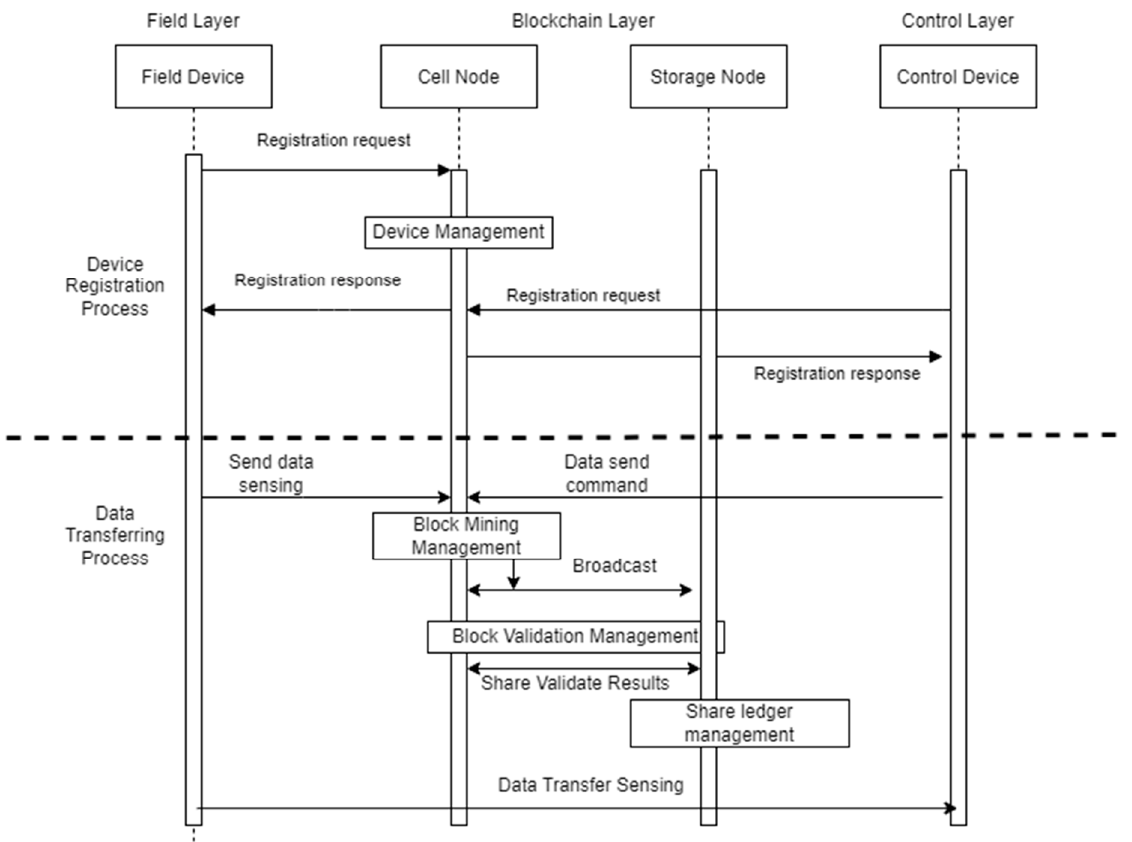
Figure 5. Proposed architecture interaction process.